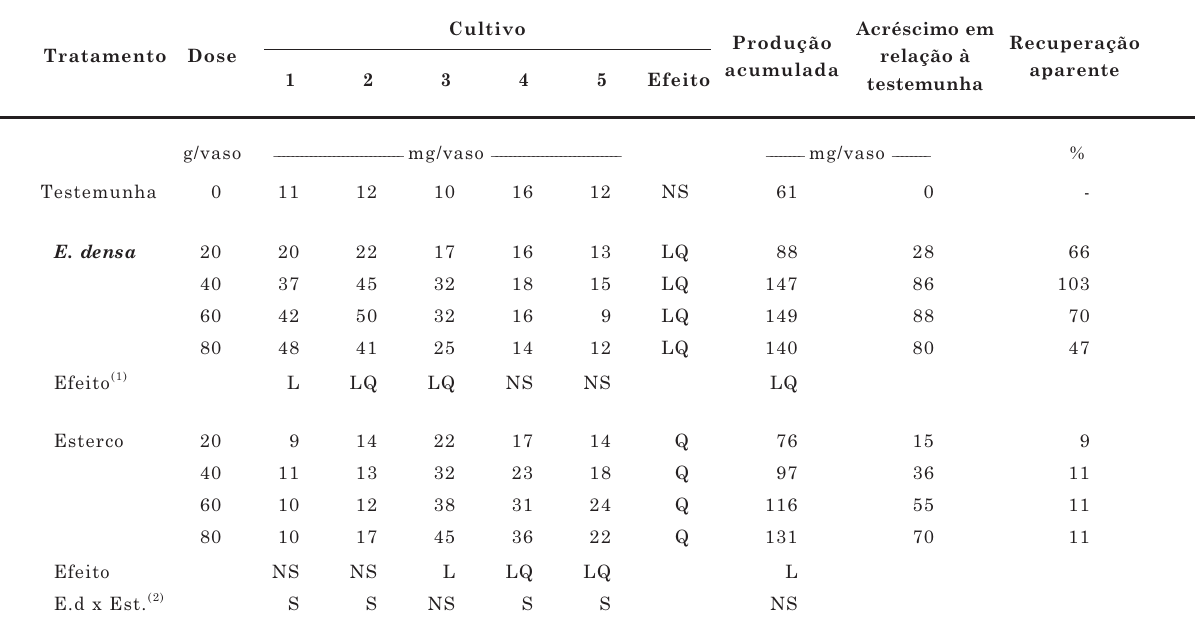
para cada cultivo e para produção